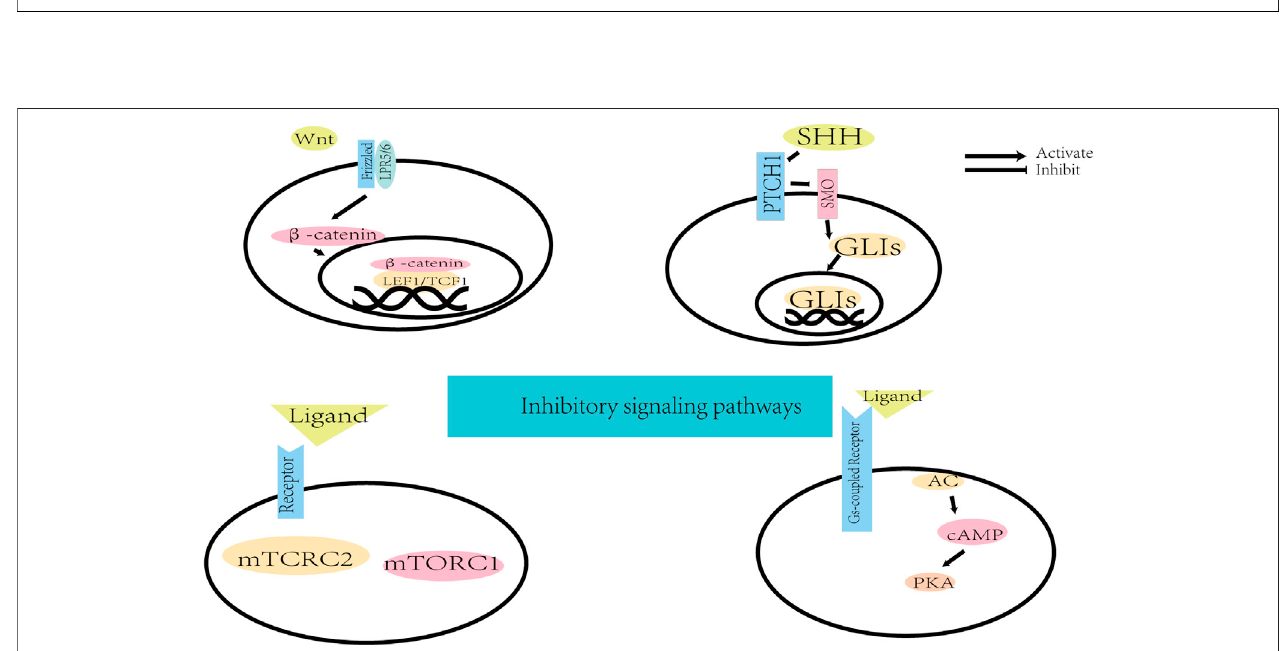
FIGURE 2 | The signaling pathways of direct neuron reprogramming by small molecules. DAPT: N-[N-(3,5-di fl uorophenacetyl)-L-alanyl]-S-phenylglycine t-butyl ester; SAG: SHH activator smoothened agonist; VPA: Valproic acid. BMP/Smad pathway: bone morphogenetic protein/Smad pathway; cAMP/PKA pathway: cyclic adenosine monophosphate/protein kinase A system pathway; JAK-STAT pathway: Janus kinase-signal transducer and activator of transcription pathway; JNK pathway:JunN-terminal Kinasepathway; mTORpathway: MammalianTargetofRapamycin pathway; P38MAPKpathway: P38mitogen-activatedproteinkinase pathway; ROCK pathway: Rho-associated protein kinase pathway; SHH pathway: Sonic Hedgehog pathway; TGF- β pathway: transforming growth factor-beta pathway; Wnt/GSK-3 pathway: (Wingless/integrated)/glycogen synthase kinase 3 pathway.